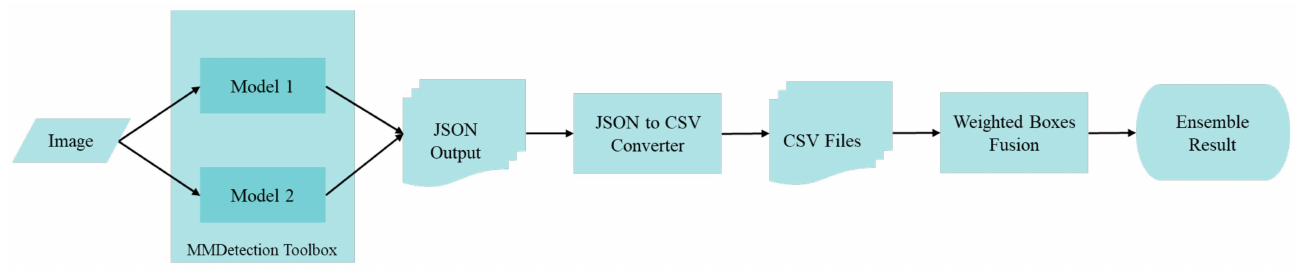
Figure 7. WFD ensemble models based on weight boxes